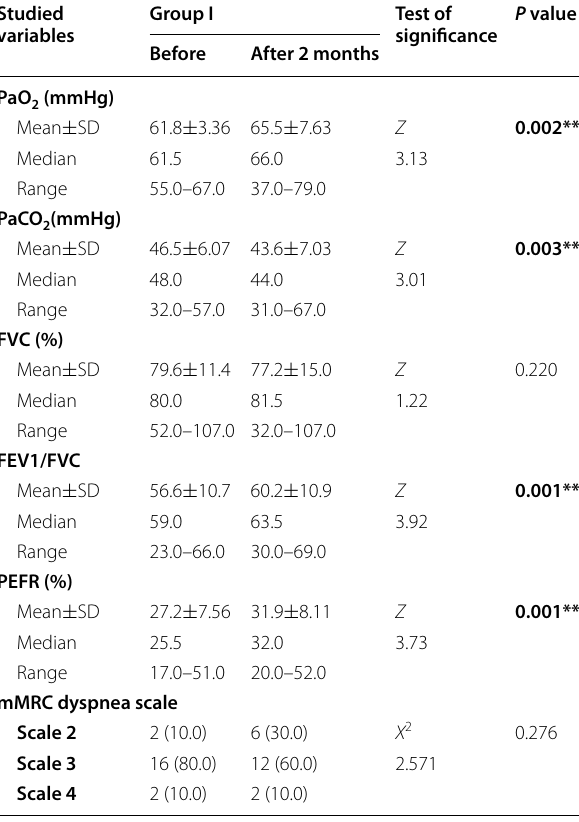
Table 7 Comparison between diaphragm finding by ultrasound 20) before and after 2 months among group =